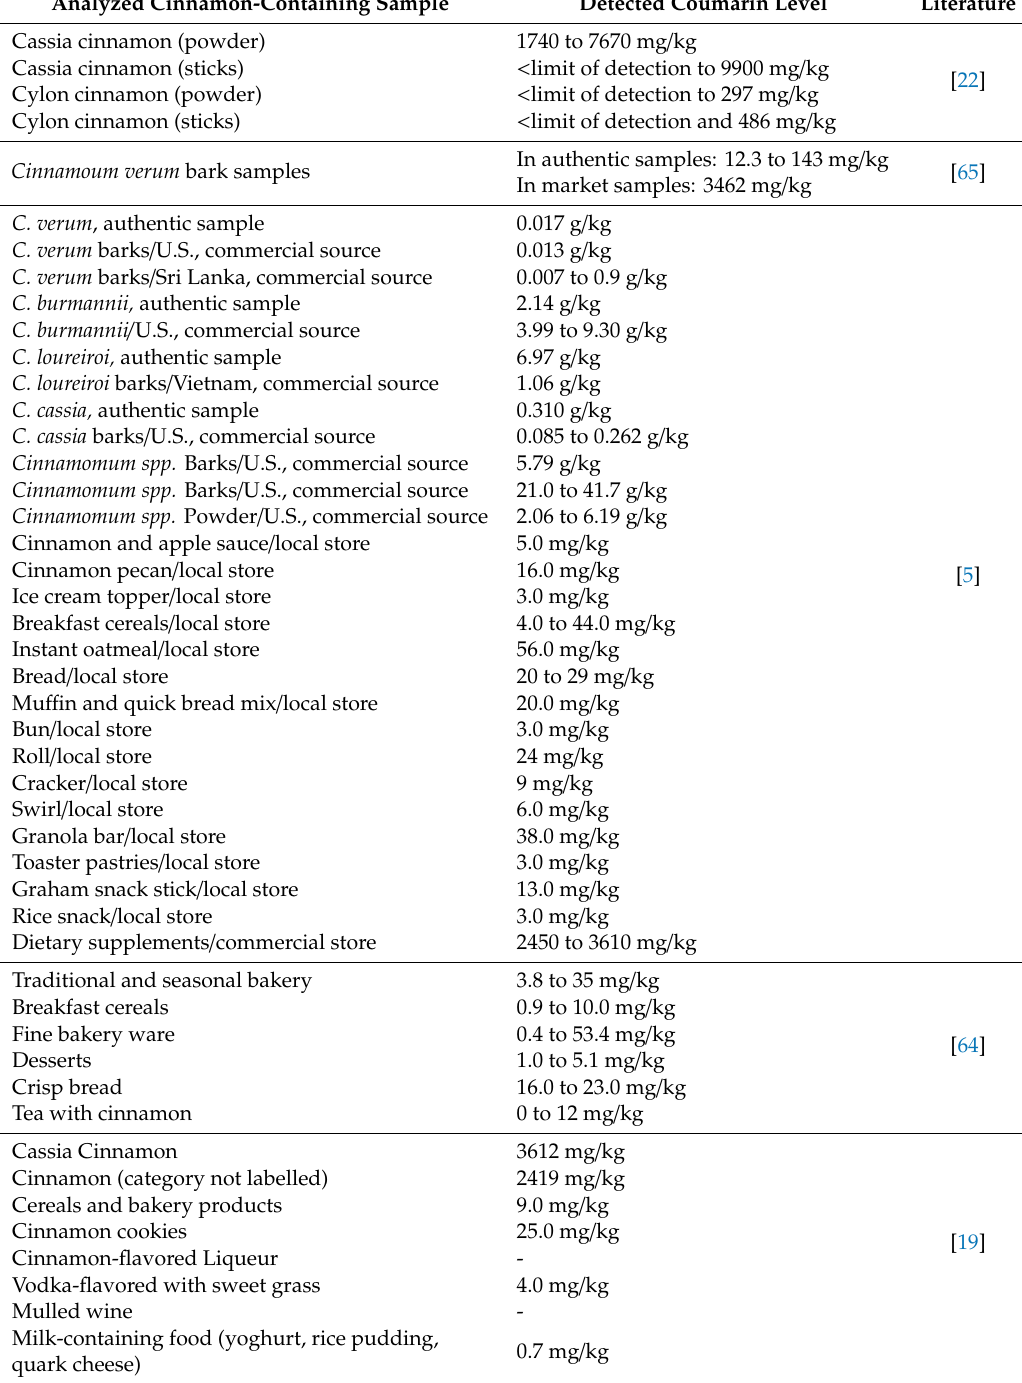
Table 4. Coumarin content on cinnamon and cinnamon-containing